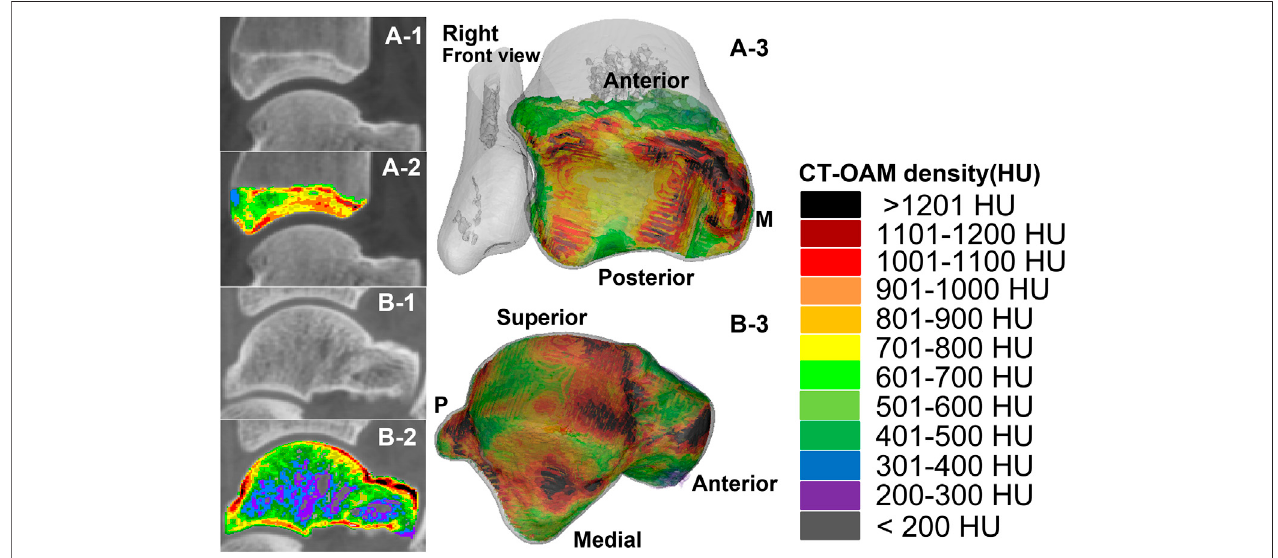
FIGURE 1 | The measurement range and reconstruction model of the subchondral bone of the distal tibia and the talus in the two groups of subjects. A-1 and A-2 werecomputedtomography(CT)imagesandCTOAMimagesofthedistaltibia;A-3isthereconstructedimageofeachbonedensitytissueofthedistaltibia.B-1andB-2 were computed tomography (CT) images and CTOAM images of the talus; B-3 is the image of bone density tissue of the talus after reconstruction.